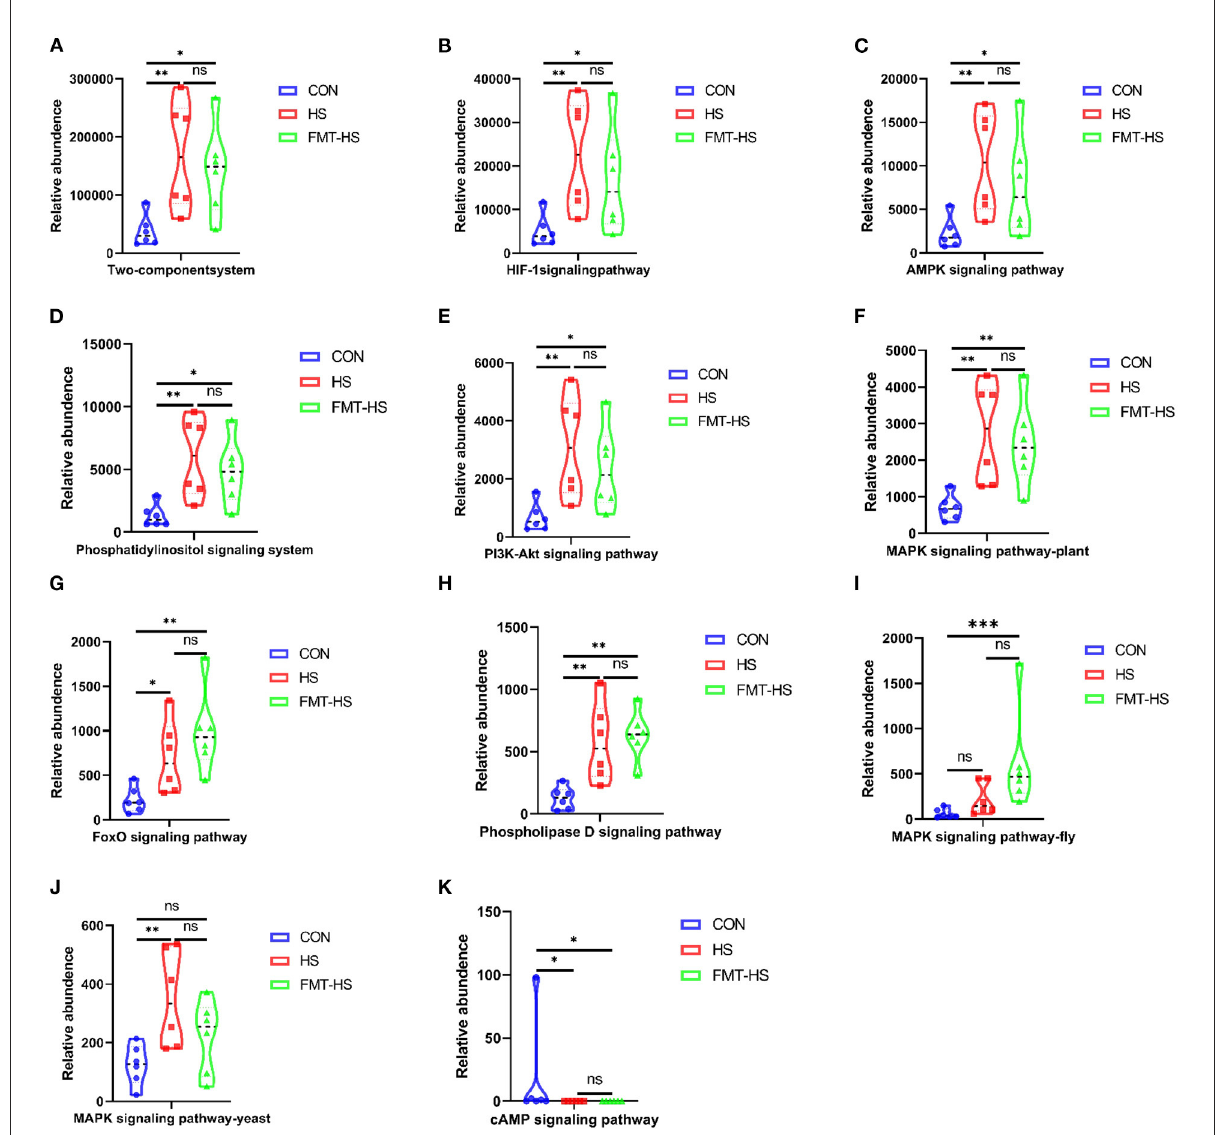
FIGURE9 Signal transduction pathways enriched by the significantly different genera in high salt (HS) induced mice which were screened by fecal microbiota transplantation ( n = 6). The relative abundance of Two-component system, HIF-1 signaling pathway, AMPK signaling pathway, Phosphatidylinositol signaling system, PI3K-Akt signaling pathway, MAPK signaling pathway-plant, FoxO signaling pathway, Phospholipase D signaling pathway, MAPK signaling pathway-fly, MAPK signaling pathway-yeast and cAMP signaling pathway (A–K) . * p < 0.05, ** p < 0.01, *** p < 0.001; ns, no